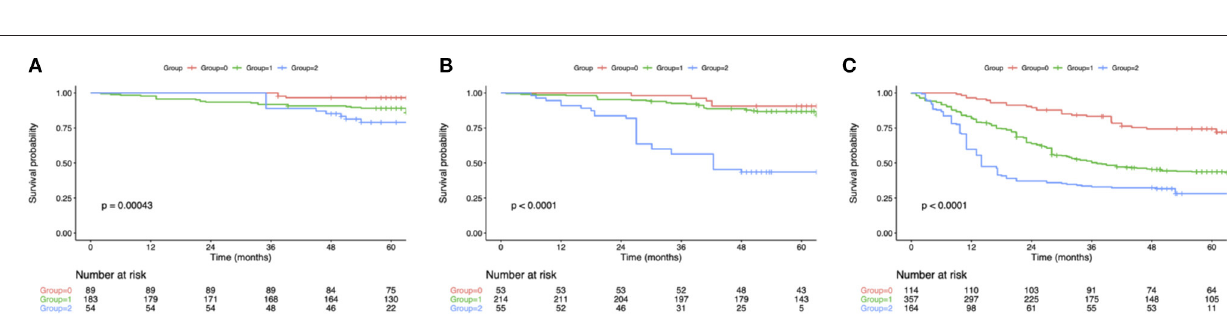
FIGURE 2 | Kaplan-Meier analysis of OS of GC patients at each pTNM stage according to the NPS. (A) Association of the NPS with OS of patients with stage I GC. (B) Association of the NPS with OS of patients with stage II GC. (C) Association of the NPS with OS of patients with stage III GC. OS, overall survival; NPS, naples prognostic score; GC, gastric